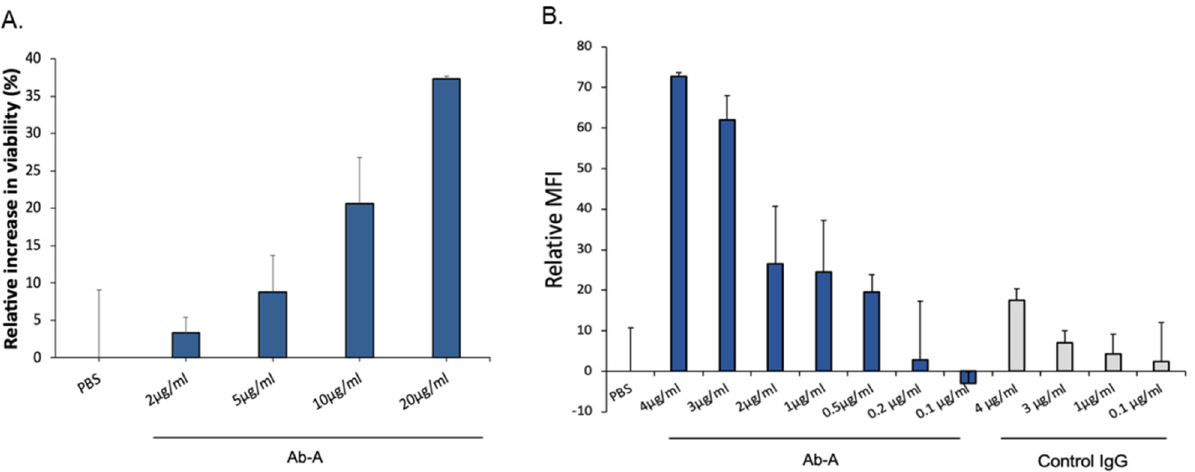
Figure 2. The effect of Ab-A on SH-SY5Y neuronal cell viability after oligomeric TTR-induced toxicity and on the uptake of aggregated TTR by microglia. ( A ) The effect of Ab-A on the viability of neuronal cells (SH-SY5Y cell line) exposed to 5 µ M oligomeric TTR and either PBS or increasing doses of Ab-A. The y-axis represents the relative increase in cell viability resulting from treatment with Ab-A antibody as compared to treatment with PBS. Samples were measured in quadruplicate (mean ± standard deviation). ( B ) Ab-A increases the uptake of fluorescent-aggregated TTR by mouse microglia BV2 cells. The y-axis represents the relative median fluorescence intensity (MFI) measured by flow cytometry. Samples were measured in triplicate (mean ± standard deviation). One representative result out of three is shown.